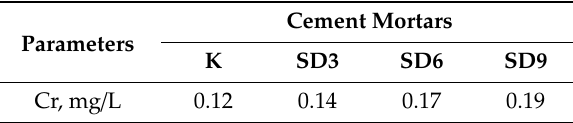
Table 5. Tests in chromium leaching from cement